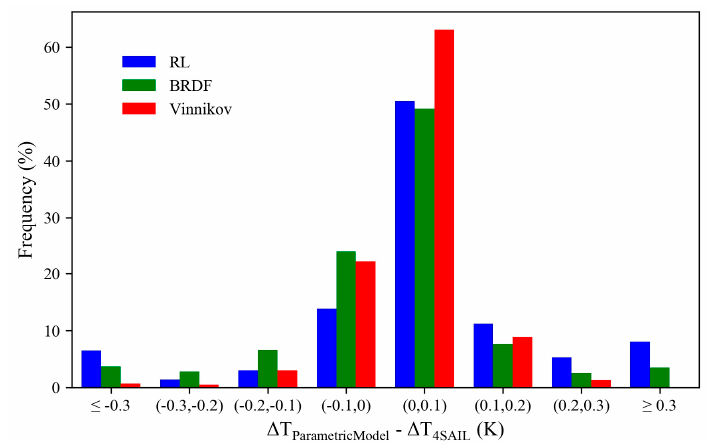
Figure 3. Histogram of the difference between parametric models and Scattering by Arbitrarily Inclined Leaves (4SAIL) simulated anisotropy.